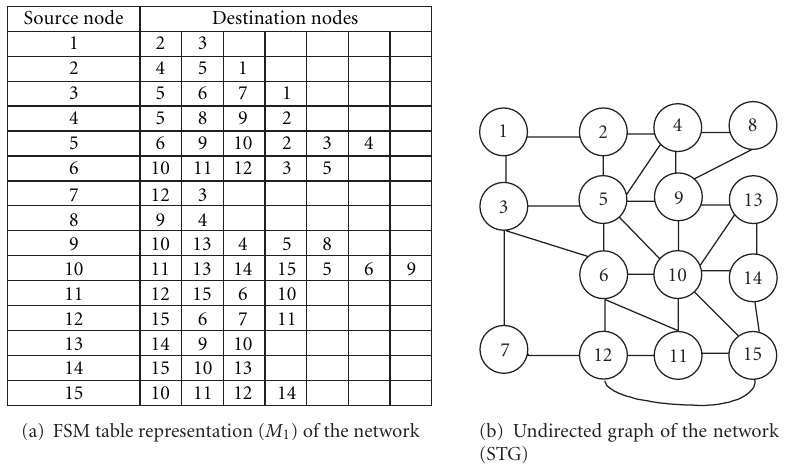
Figure 2: Network with 15 stations.